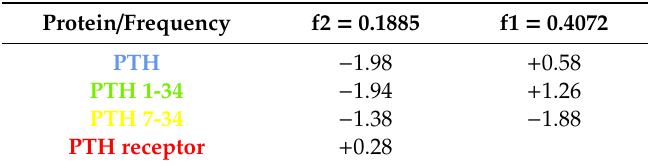
Table 1. Phases for parathyroid hormone protein, fragments and receptor. The colour of each protein corresponds to the colour of phases in Figure 5.